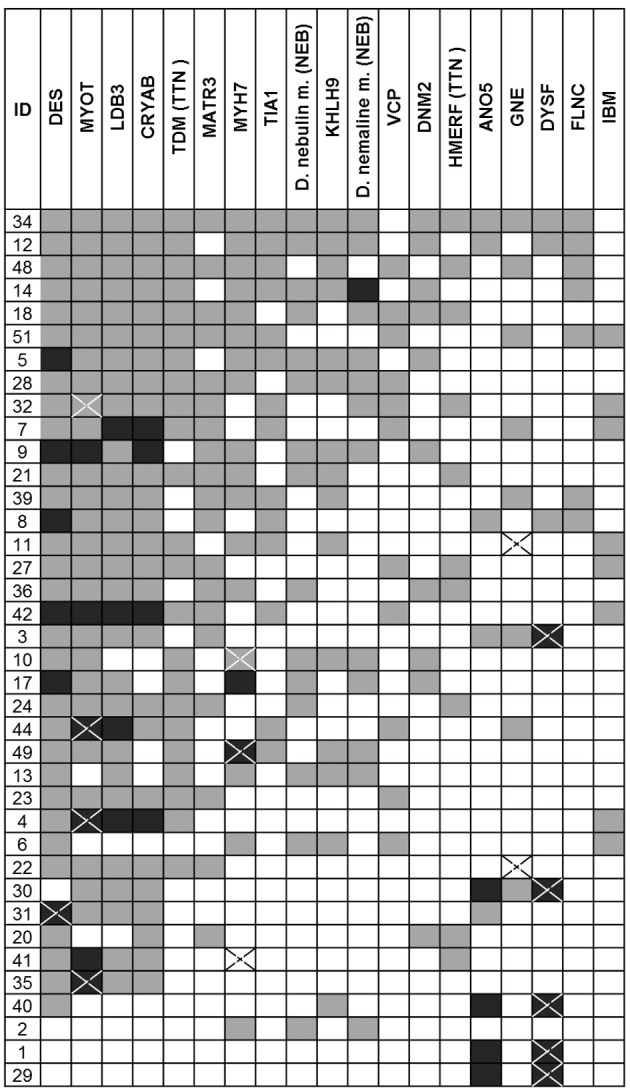
Results of the clinical-pathological re-evaluation. The diseases are reported using gene symbols apart for IBM. For TTN and NEB two different phenotypes were considered. FLNC refers to the phenotype described in the distal ABD-filaminopathy. In black the disease scored as typical and in gray as consistent. A cross indicates the gene confirmed as positive. HMERF, hereditary myopathy with early respiratory failure; TMD, tibial muscular dystrophy.